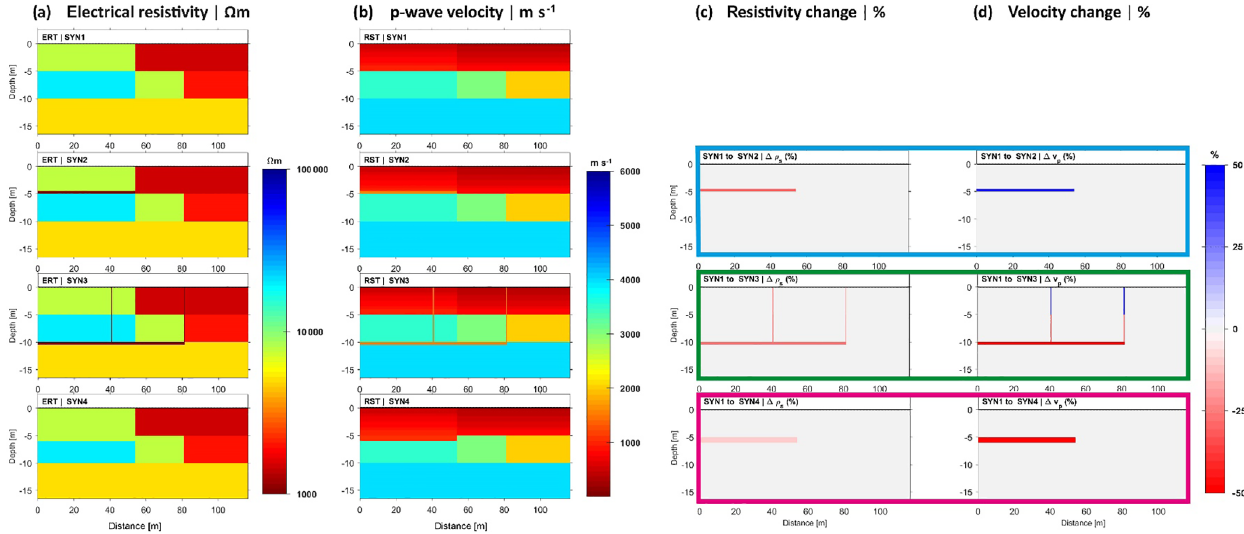
Figure 4. Synthetic model scenarios for (a) ERT and (b) RST, and percentage changes between (c) ρ s and (d) v p of the three scenarios with respect to the baseline model.